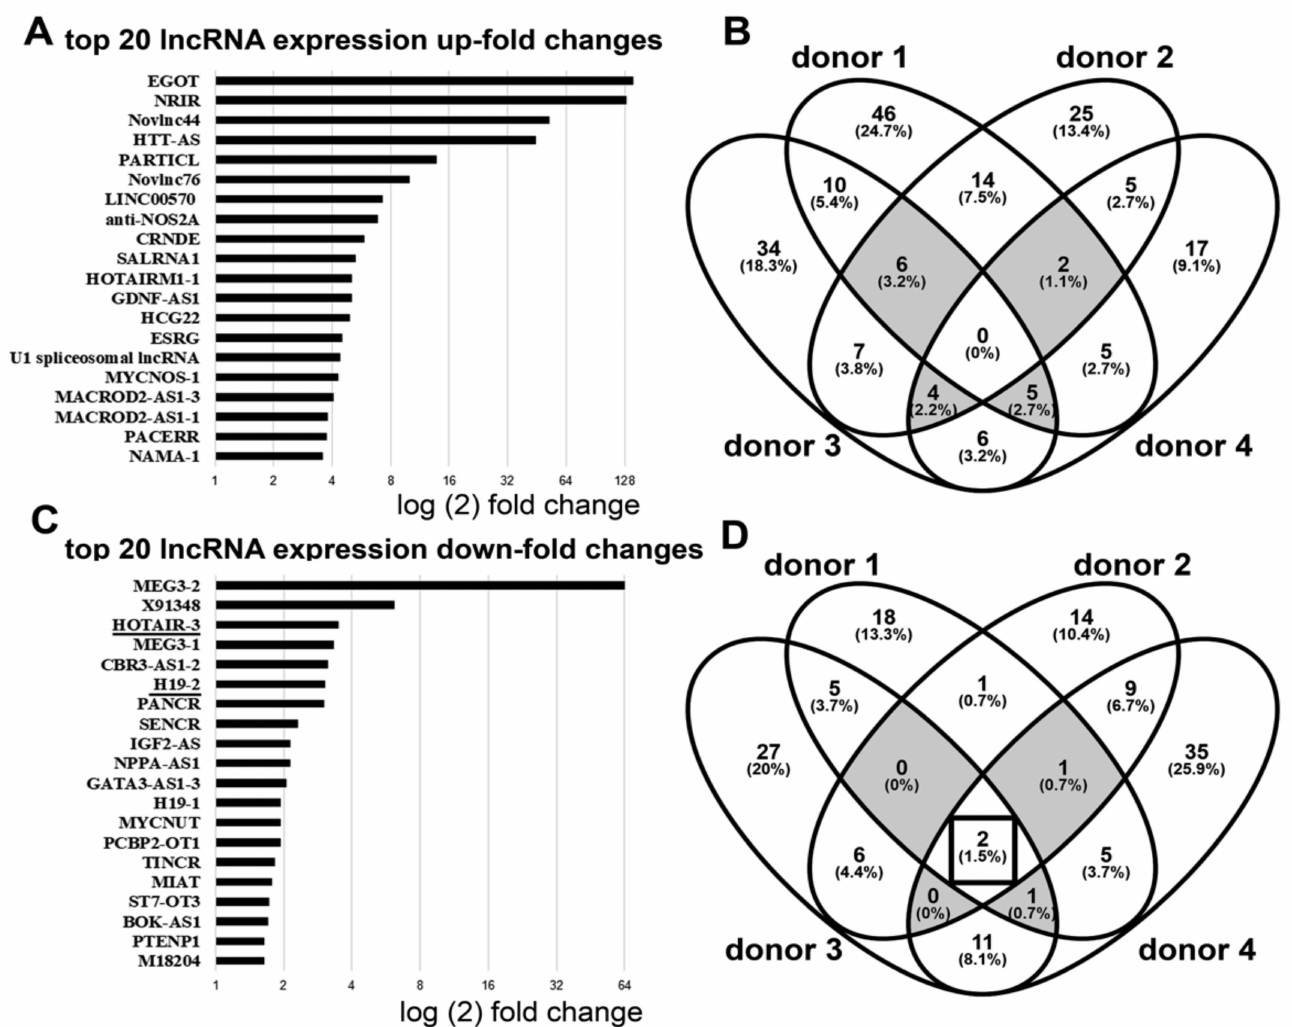
Figure 1. Differential expression of lncRNAs between ADAM15-expressing and non-expressing synovial fibroblasts (SF) under mechanical strain. ( A – D ) SF ( n = 4), either expressing ADAM15 or downregulated with a specific siRNA, were strained for 3 h using the Flexcell System (elongation 15%, frequency 1 Hertz). Reverse-transcribed cDNAs were then amplified in Arraystar lncRNA PCR-plates, and the fold change of up-/down-regulation of gene expression was calculated with the 2 − ∆∆ Ct method. ( A,C ) Top 20 lncRNAs differentially up- and downregulated in ADAM15-expressing versus non-expressing SF. ( B,D ) Venn diagram of all differentially expressed lncRNAs with a 2-fold change up/downregulation, identifying HOTAIR and H19-2 as differentially downregulated lncRNAs in all 4 SF (underlined in C ; intersection, boxed in D ). Intersections among 3 donors are shown in